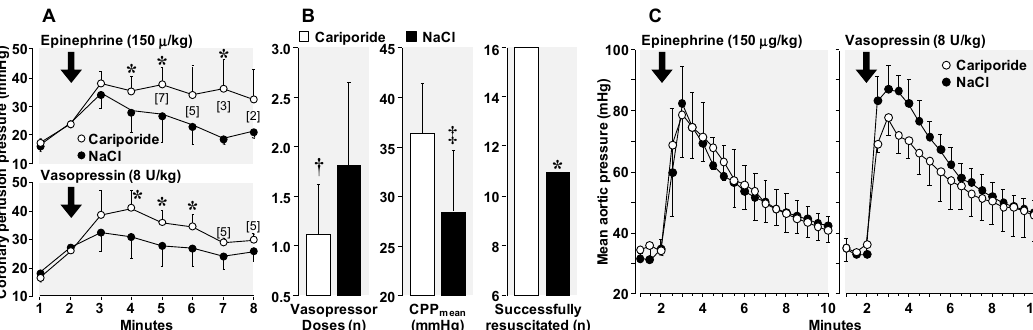
Figure 5. ( A ) Coronary perfusion pressure during chest compression in rats that received epinephrine (upper panel) or vasopressin (lower panel). Within each series, 16 rats were randomized to receive immediately before starting chest compression a 3 mg / kg bolus of cariporide or 0.9 % NaCl. With cariporide several rats experienced spontaneous defibrillation. The numbers in brackets indicate rat that remained in ventricular fibrillation. * p < 0.05 vs. NaCl by one-way ANOVA. ( B ) Combined data from both the epinephrine and vasopressin series in rats randomized to cariporide ( n = 16) or NaCl ( n = 16). CPPmean = Coronary perfusion pressure averaged through min 3 and 8 of chest compression. * p < 0.05 vs. NaCl by Fisher’s exact test; † p < 0.005, ‡ p < 0.0005 vs. NaCl by one-way ANOVA. ( C ) Aortic pressure during in situ perfusion. The vasopressor dose was given as a bolus at two minutes of low-flow perfusion. Either cariporide or 0.9% NaCl was infused throughout the low-flow perfusion state in both epinephrine ( n = 8) and vasopressin ( n = 8) series (adapted with permission from Kolarova et al.